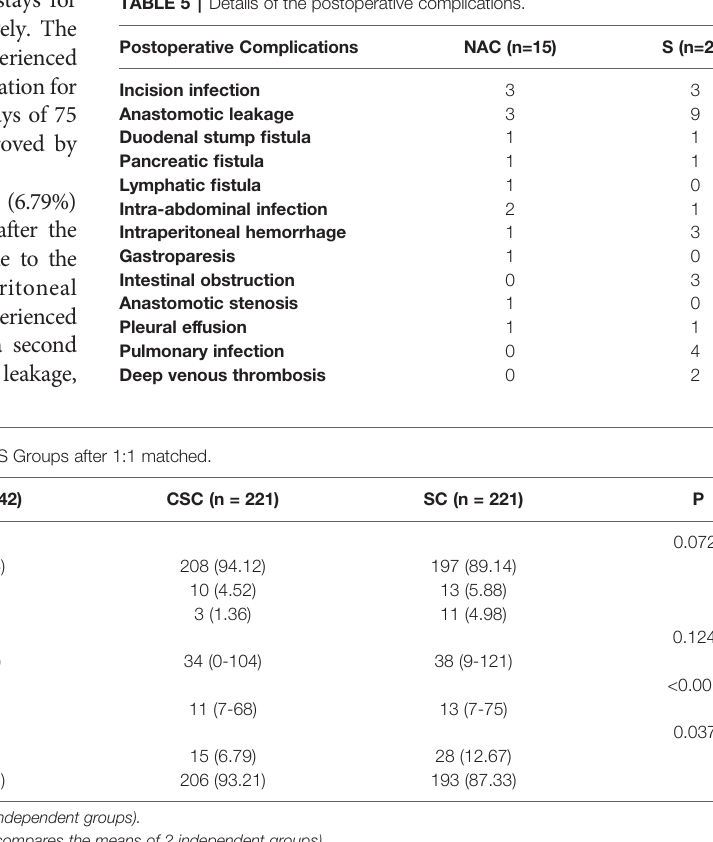
TABLE 5 | Details of the postoperative